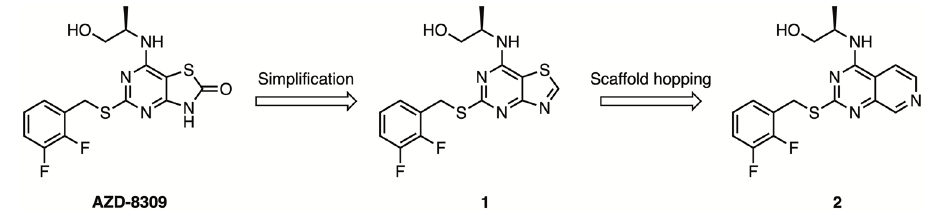
Figure 2. Previous scaffold hopping study leading to pyrido[3,4- d ]pyrimidine 2